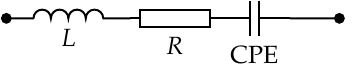
Figure 2. The equivalent scheme for describing Cu-based electrodes. Here, L inductance caused by finite-time response of the